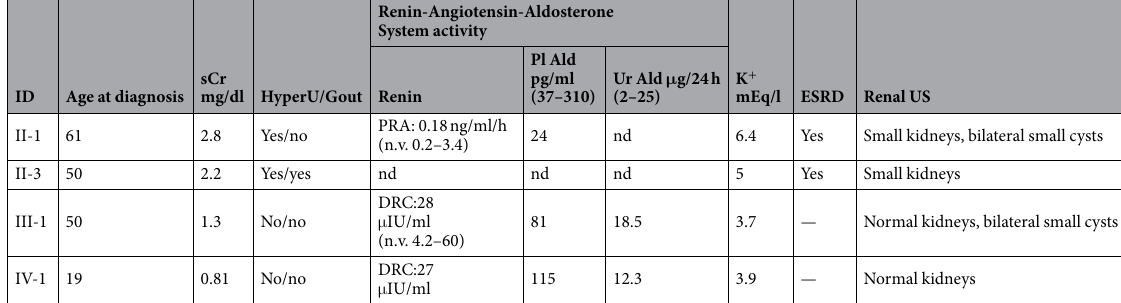
Table 1. Clinical data of family members carrying renin p.L381P mutation. ID refers to pedigree in Fig. 1a; HyperU, hyperuricemia; Pl, plasma; Ur, urinary; Ald, aldosterone; PRA, plasma renin activity; DRC, direct renin concentration; ESRD, end-stage renal disease; US, ultrasound; nd, no data; n.v. normal